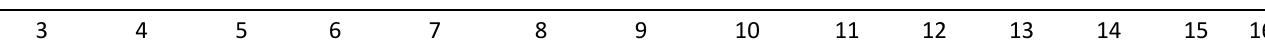
Table 1. Zero‐order correlations of key